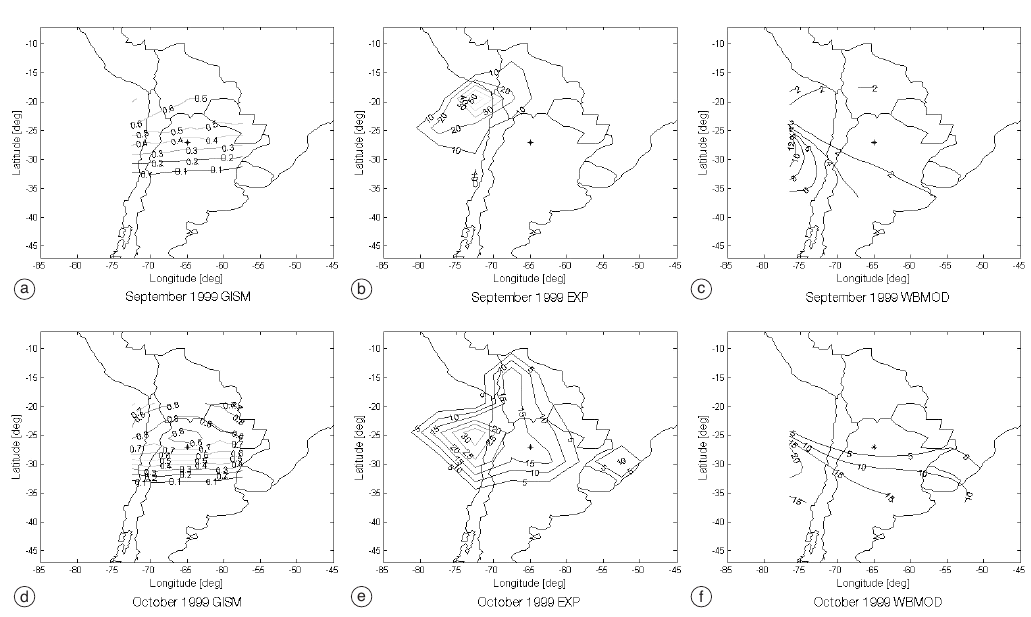
Fig. 4a-f. Percentages of occurrence of S 4 > 0.5 for experimental data and WBMOD and predicted S 4 values by GISM are shown at 22 LT (September and October